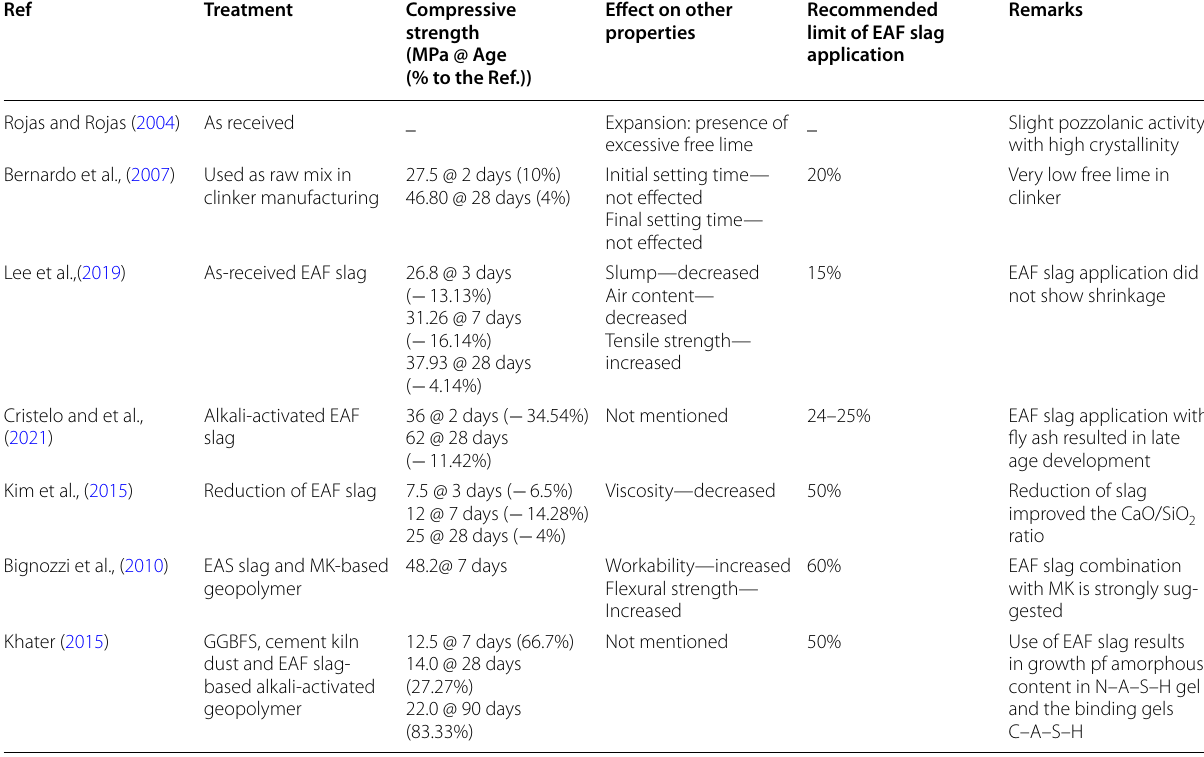
Table 6 EAF slag application as a cementitious